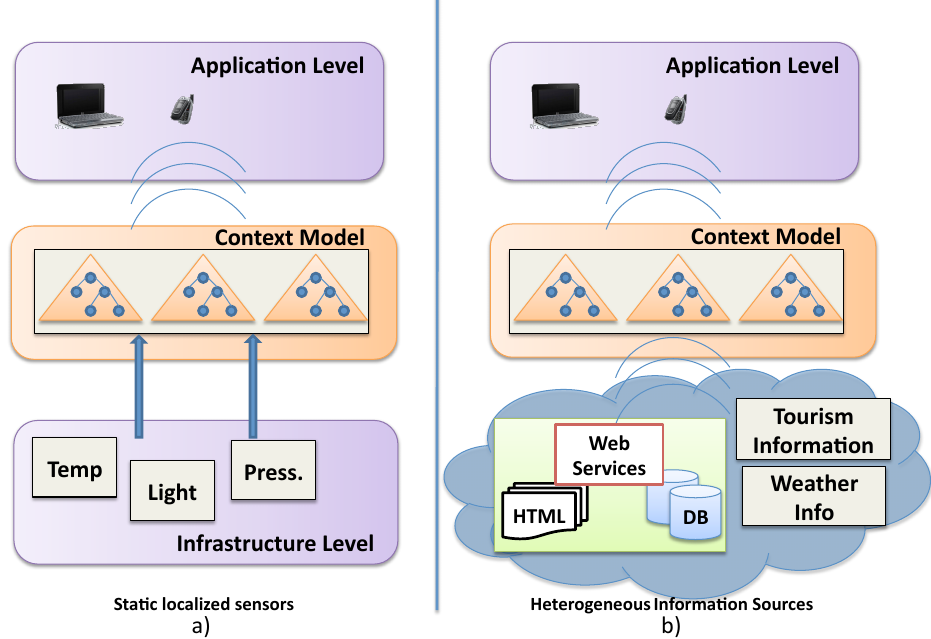
Figure 1. The CONCERT double level interoperability